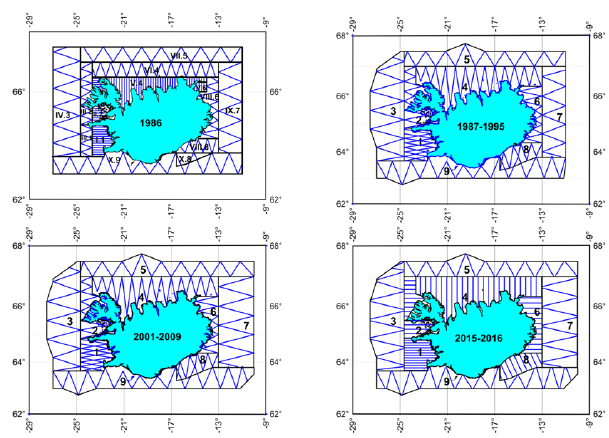
Figure 1. Stratification and transect designs used in Icelandic aerial surveys,